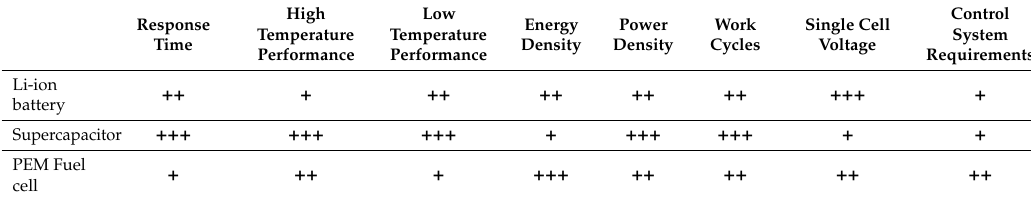
Table 1. Comparison of properties for selected types of cells. On a scale from one ( + ) to three ( +++ ), the advantages of the cell for the described parameters were determined